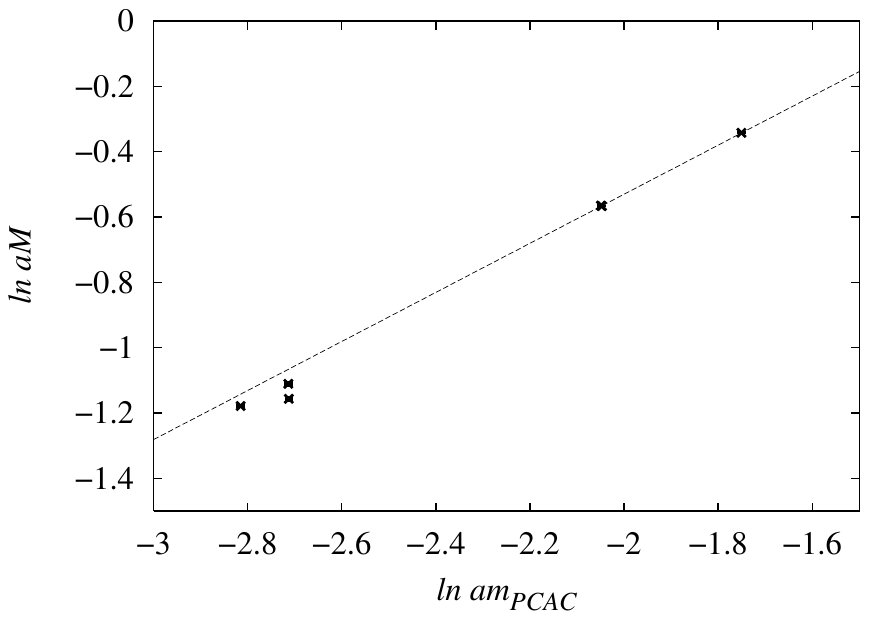
Figure 6 . Weighted averages of the logarithms of the particle masses at (cid:12) = 1 : 7 as a function of ln( am ), and the scaling (cid:12)t with exponent k = 0 : 751. Note that the second symbol from right PCAC stands for two close-by data points and the three leftmost points are not included in this (cid:12)t.